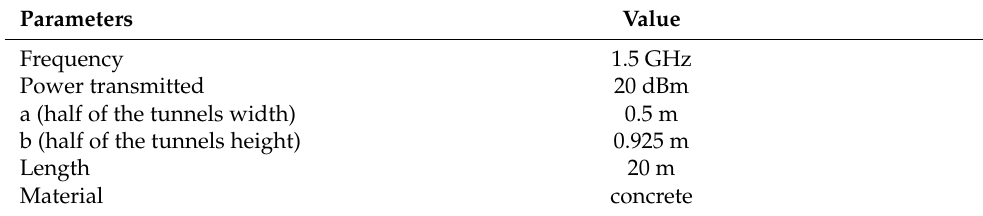
Table 2. Model example